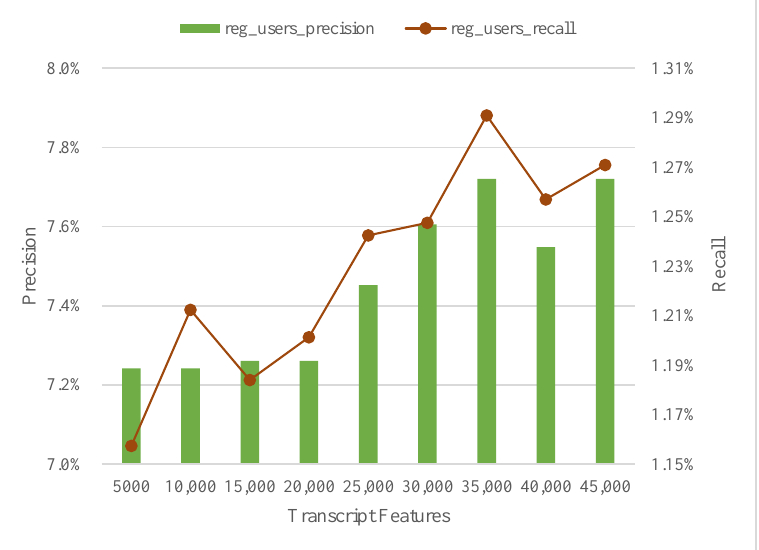
Figure 1. Precision and recall results for the regular users set with different amount of transcript